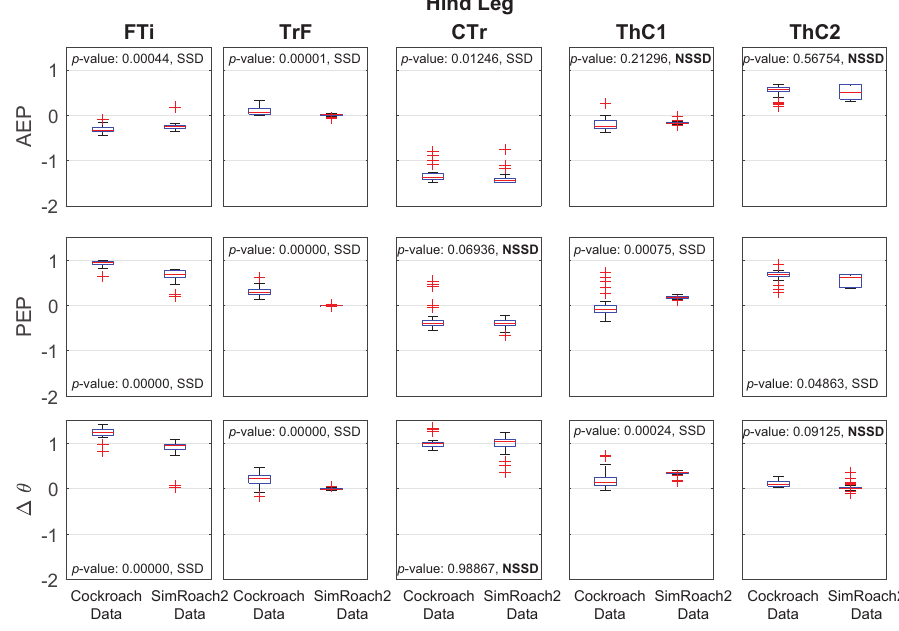
Figure 14. Hind leg anterior extreme position (AEP), posterior extreme position (PEP), and ∆ θ joint angle data in a cockroach and in SimRoach2. Twenty nine cockroach data points were used. Forty five SimRoach2 data points were used. p -values from the two-sample t -tests and whether there is a statistically-significant difference (SSD, bad match) or no statistically-significant difference (NSSD, good match) between the samples are